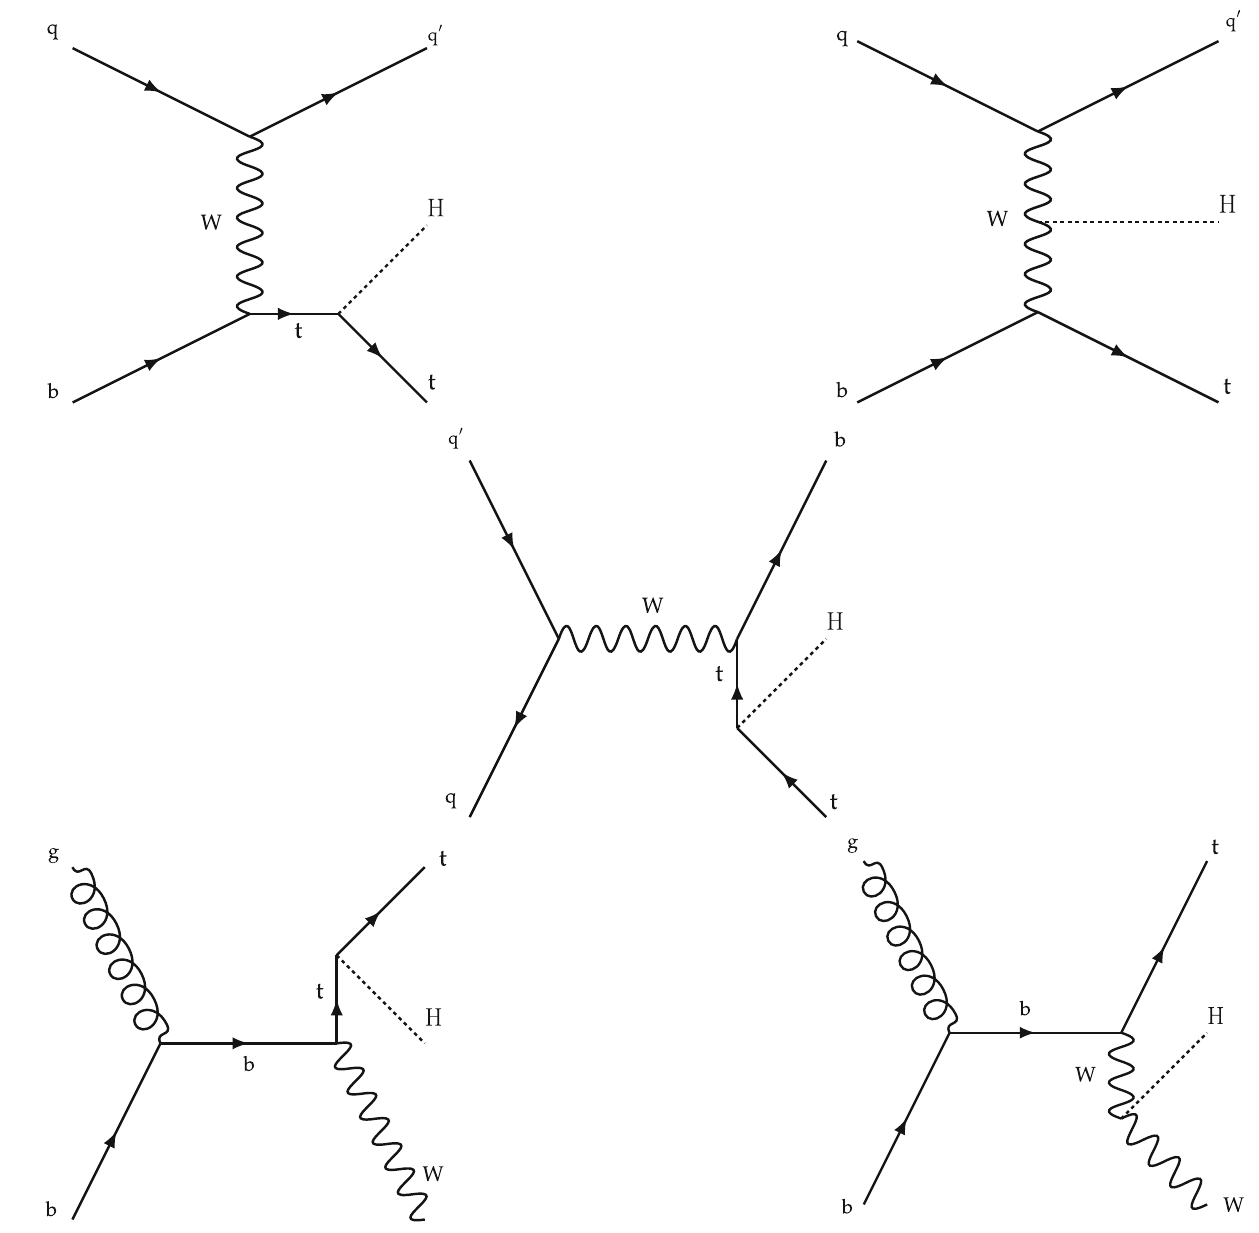
Fig. 2 Feynman diagrams at LO for tH production via the t -channel (tHq in upper left and upper right) and s -channel (middle) processes, and for associated production of a Higgs boson with a single top quark